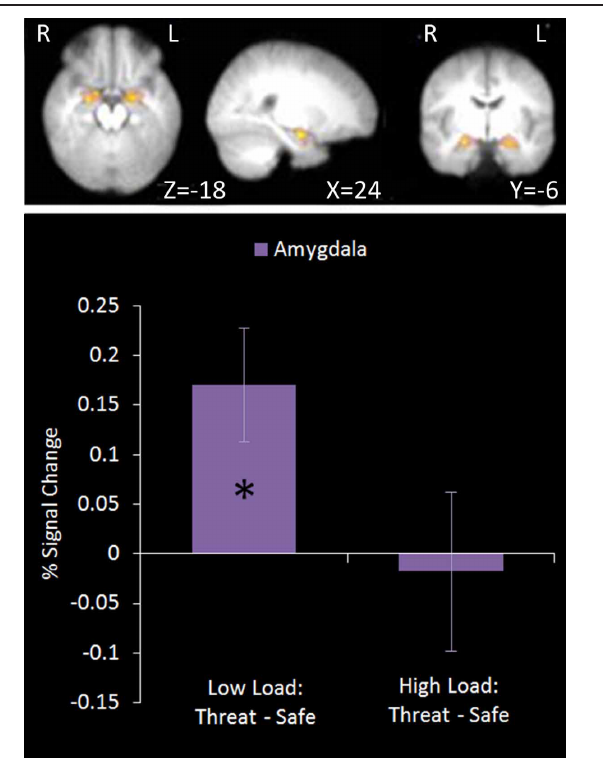
FIGURE 6 | Top: Emotion modulation contrast imaging results. This contrast revealed areas where activation was greater under Low Load/Threat conditions compared to all others. A ROI analysis was carried out using a bilateral amygdala mask (red). Bottom: Pairwise comparisons of the signal change. Activation in the amygdala cluster displayed a load-dependent modulation by threat with increased amygdala activation under threat compared to safety in Low Load but not High Load conditions [Low Load/Threat—Low Load/Safe: mean difference = 0.170%, S . D = 0 . 172, t ( 17 ) = 4 . 191, p = 0 . 001; High Load/Threat—High Load/Safe: mean difference = 0.018%, S . D = 0 . 254, t ( 17 ) = 0 . 294, p < 0 . 772]. Error bars display within-subject standard error (Morey, 2008). ∗ p < 0 . 05